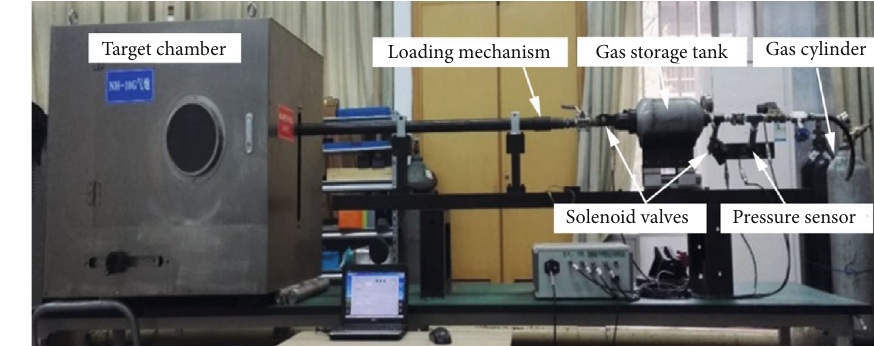
Figure 2: Air cannon system.